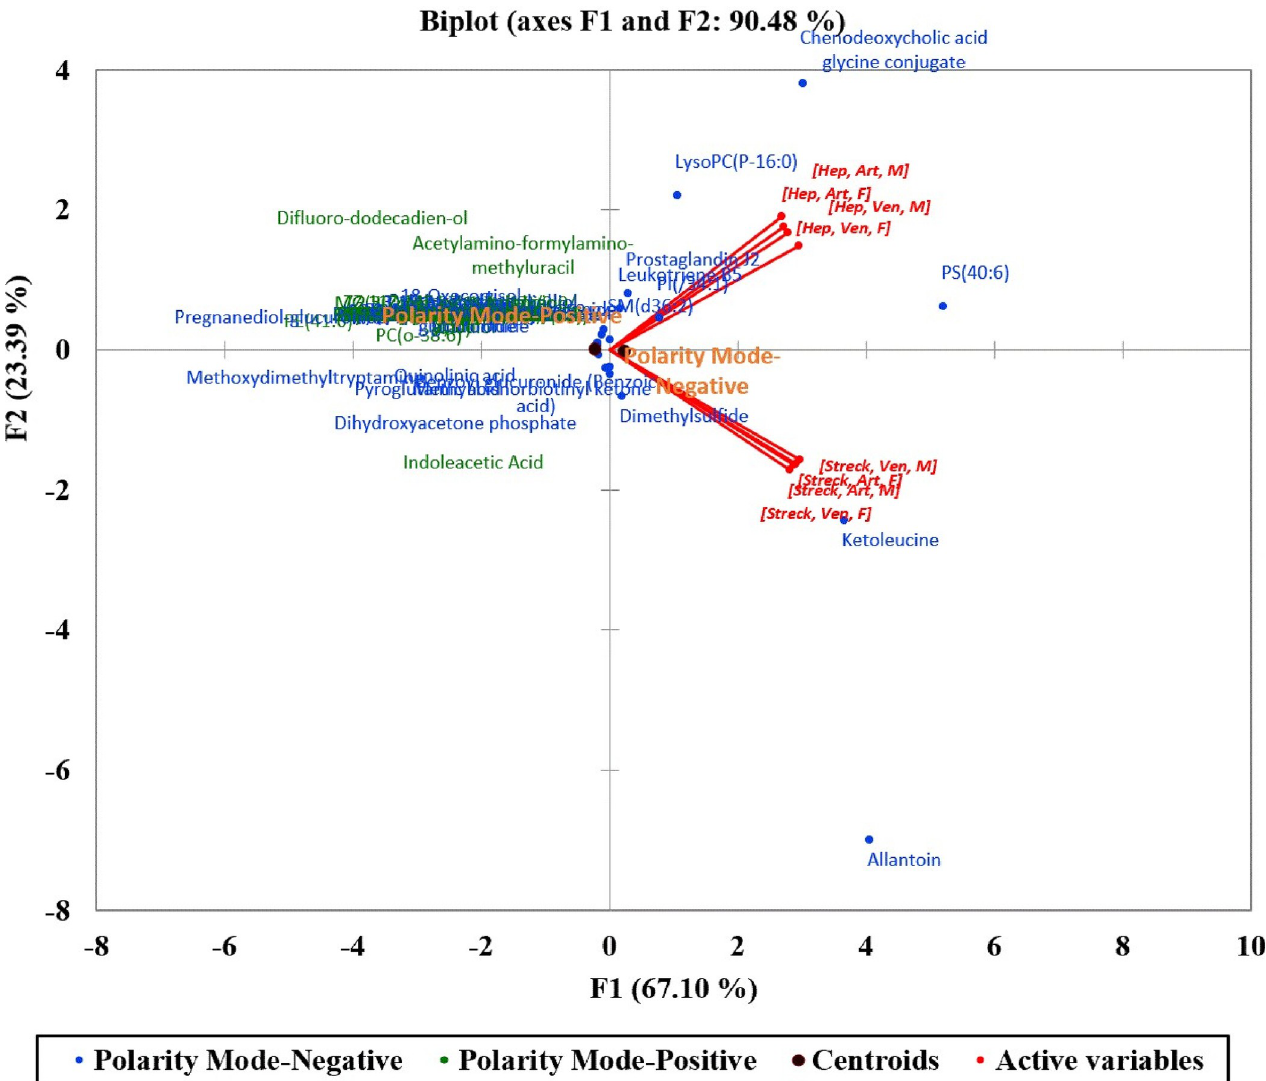
Fig 2. Principal component analysis (PCA) biplot (axes F1 and F2: 90.48%) of detected metabolites collected from 42 patients.